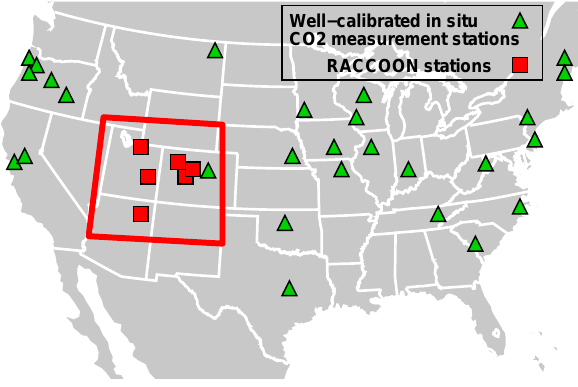
Fig. 1. Map of RACCOON domain. The complimentary position- ing of the RACCOON mountaintop network of autonomous CO 2 mole fraction surface sites is shown with reference to NOAA’s CO 2 mole fraction measurement network, Penn State’s Midcontinental Ring 2 sites, the ORCA network, and other well-calibrated in situ CO 2 mole fraction sites in the Continental